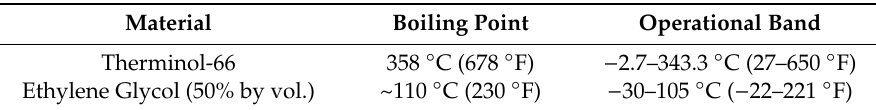
Table 2. Fluid operational limits at 1